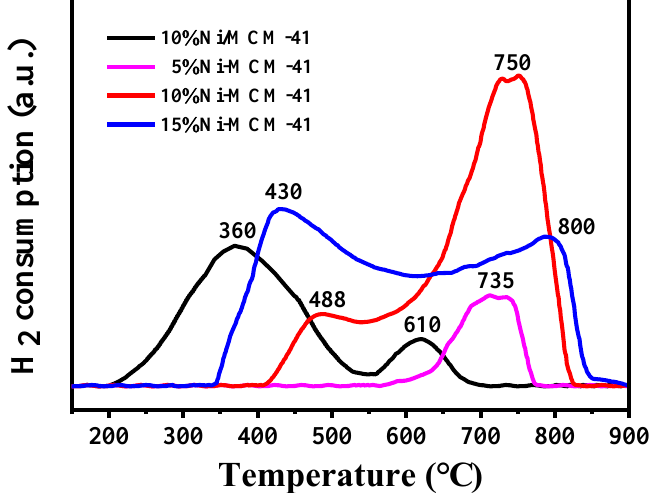
Figure 6. H 2 -TPR images of fresh Ni/MCM-41 and Ni-MCM-41 catalysts.